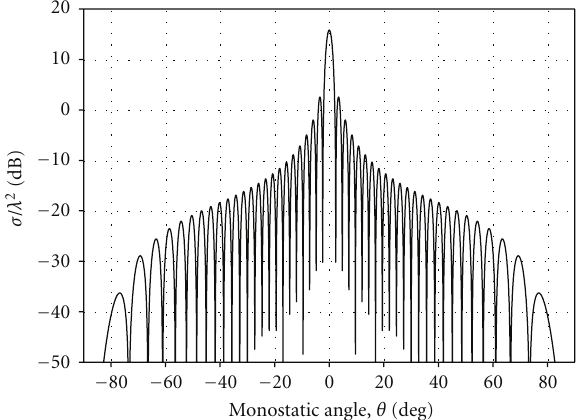
Figure 16: RCS of series-fed 30-element linear dipole array. θ s = 0 ◦ , d = 0 . 4 λ , l = 0 . 5 λ , and r = 0 .